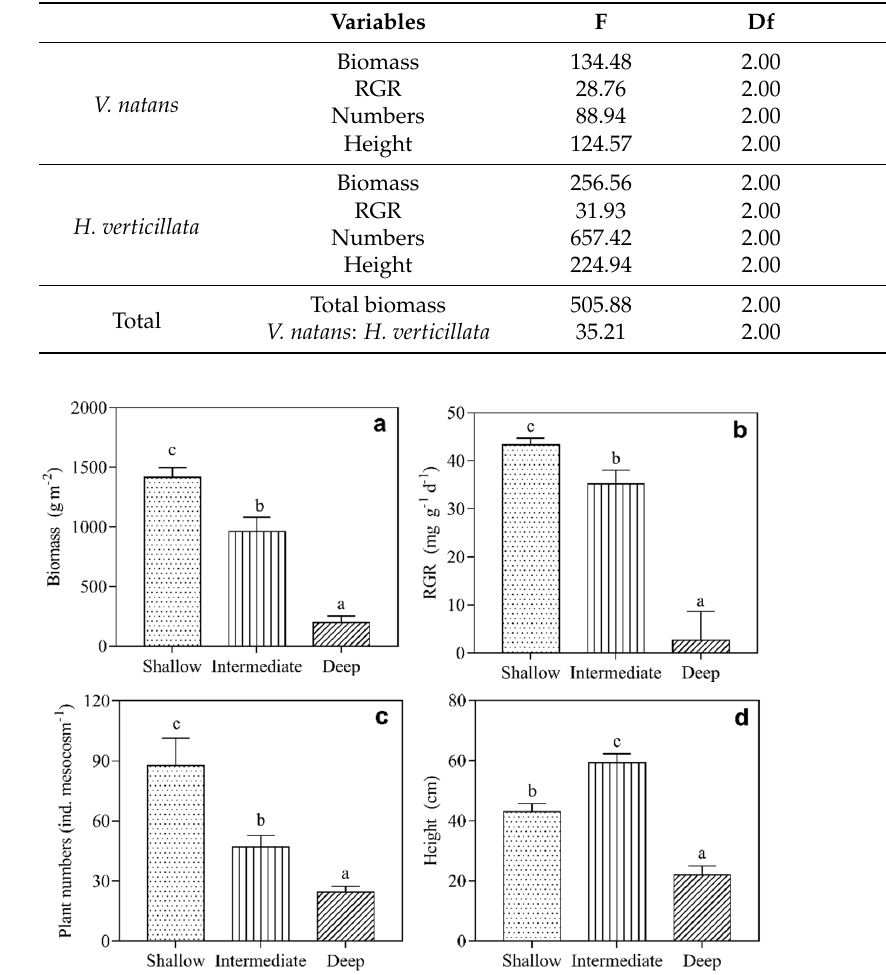
Table 2. One-way ANOVA results of the growth and morphological indices of both submerged Light (target depth: surface) macrophytes among different water depths.